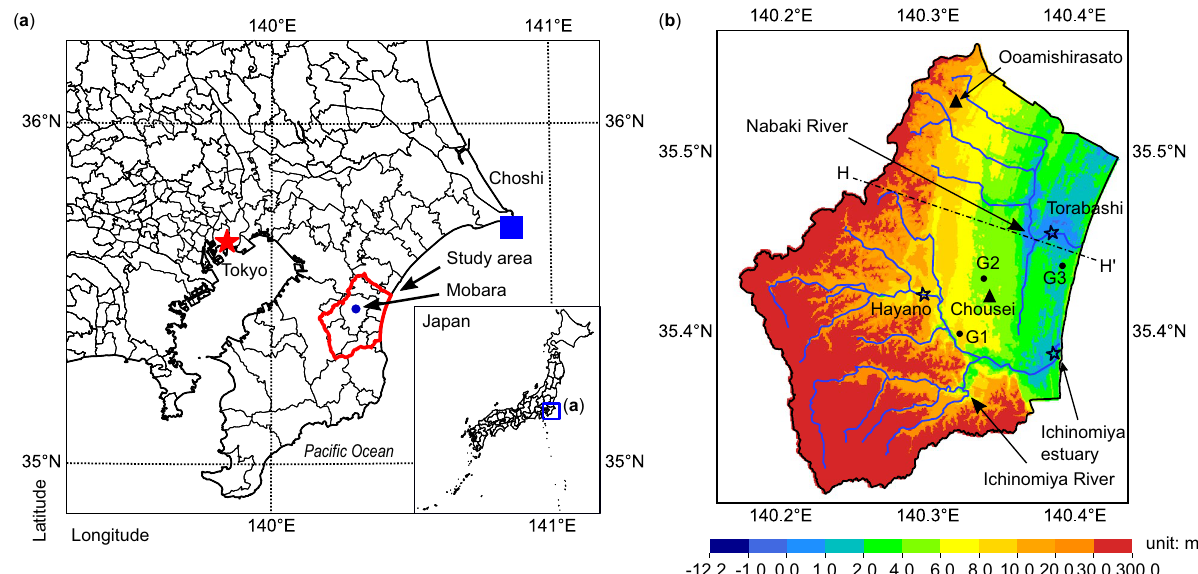
Figure 1. Location and topographic map of the study area. ( a ) The location of research site. Choshi is a tidal station, and the measured sea levels at Choshi were used as the coastal boundary conditions in the model. ( b ) The topographic map in the year 2013. Two river systems: Nabaki River and Ichinomiya River, flow through the study area. The Chosei station showed around 0.11 m subsidence, and the Oamishirasato station around 0.13 m subsidence due to the 2011 Tohoku earthquake 29 . Torabashi, Hayano and Ichinomiya Estuary are the river gauging stations, and the measured river water levels were used to calibrate model parameters (Fig. S3). G1, G2 and G3 are groundwater observation wells, and the measured groundwater levels were also used to calibrate the model parameters (Fig. S4). The modeled geological cross-section along the line H–H’ is shown in Fig. S2(c). (Figure generated using Matplotlib v. 2.2.3, http://www.matpl otlib .org. Local basemaps from Geospatial